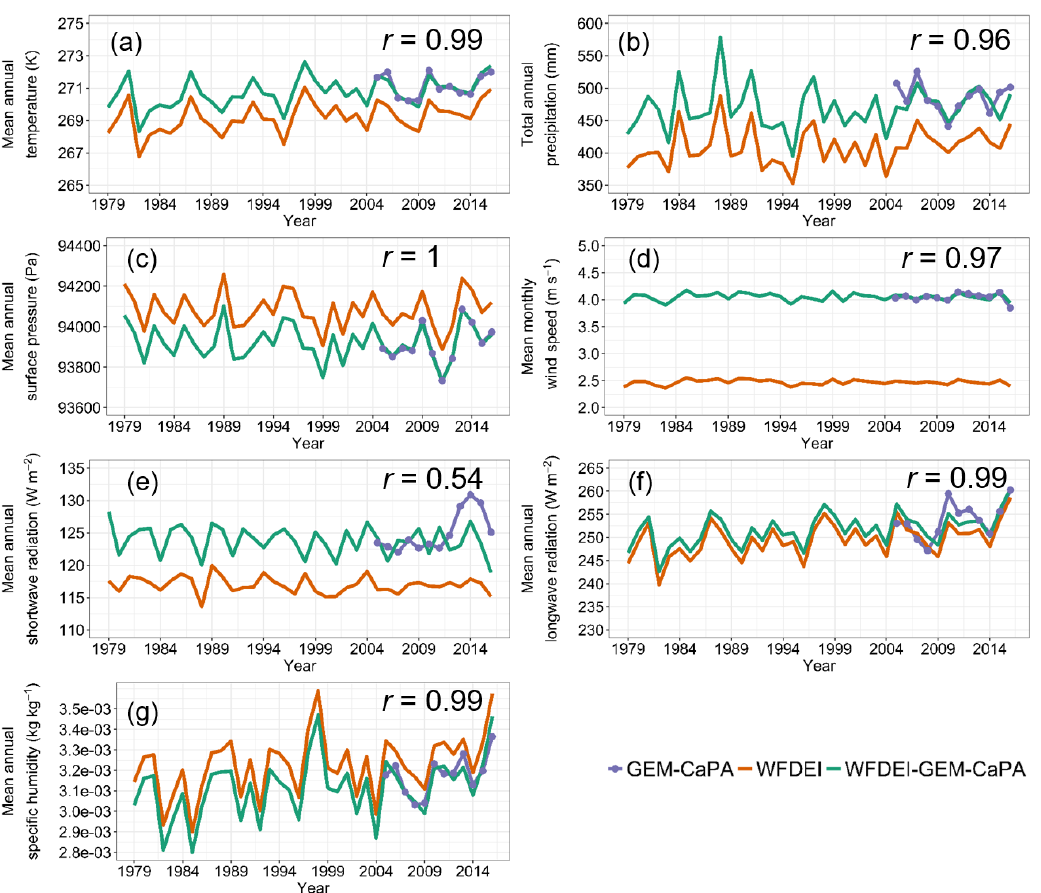
Figure 5. Time series of GEM-CaPA (dark slate blue), WFDEI (orange), and WFDEI-GEM-CaPA bias-corrected data (green) for air tem- perature (a) , precipitation (b) , surface pressure (c) , wind speed (d) , shortwave radiation (e) , longwave radiation (f) , and specific humidity (g) during the periods 2005–2016 (GEM-CaPA) and 1979–2016 (WFDEI and WFDEI-GEM-CaPA). The correlation ( r ) between the WFDEI and WFDEI-GEM-CaPA annual series is indicated for each